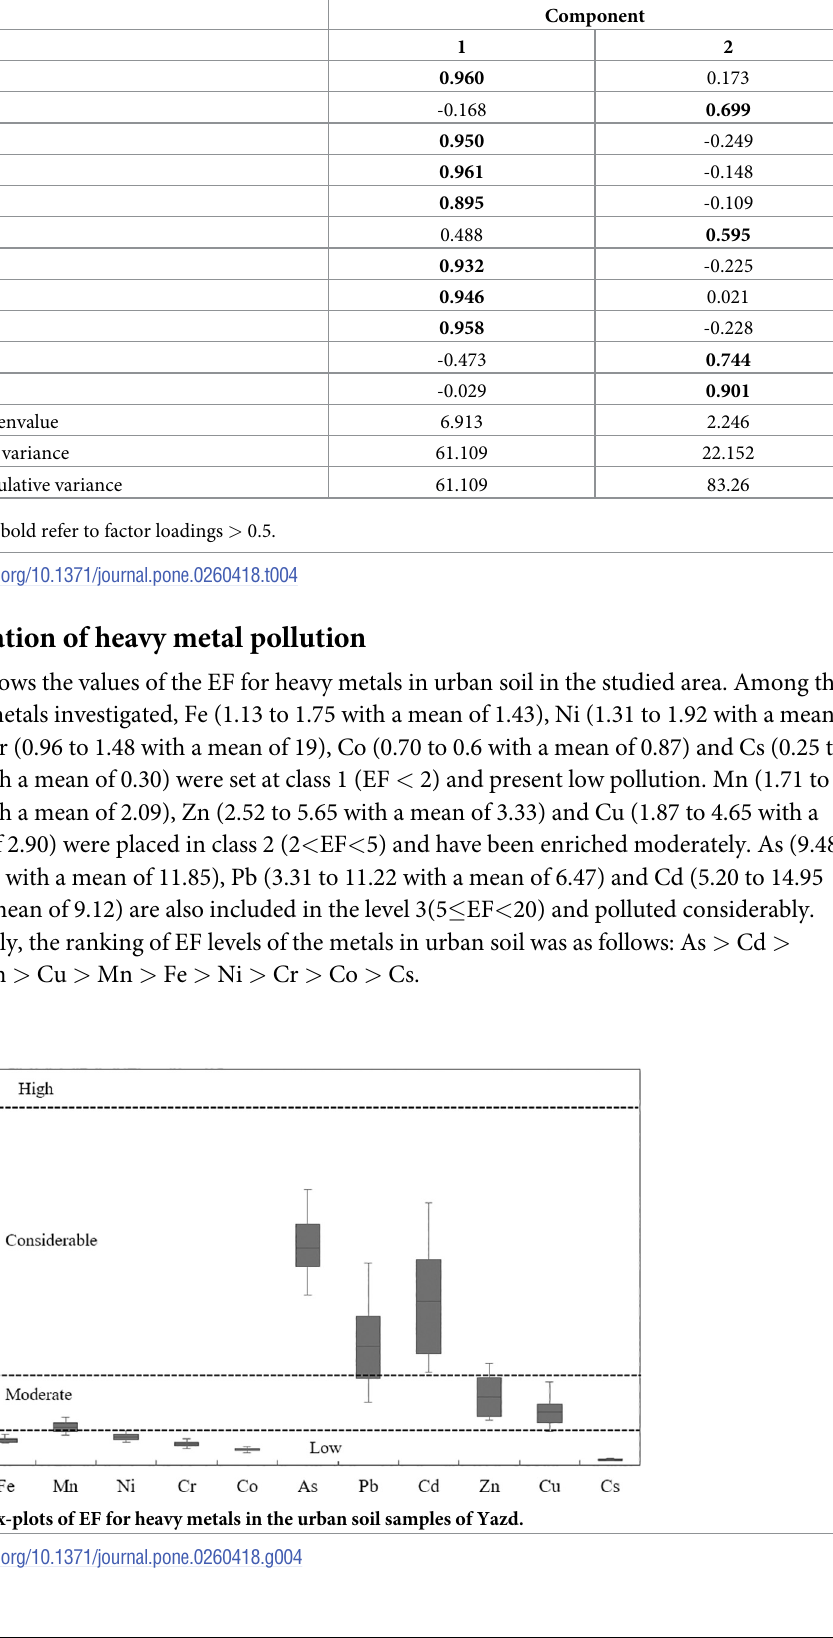
Table 4. Rotated component matrix for the PCA loadings of heavy metals in urban soil of Yazd city.